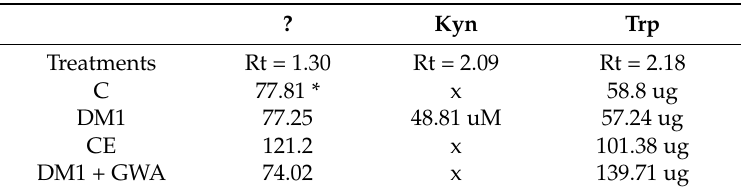
Table 4. Composition of amino acids present in plasma of rats submitted to treatments, evaluated by HPLC. ? Kyn Trp Treatments Rt = 1.30 Rt = 2.09 Rt = 2.18 C 77.81 * x 58.8 ug DM1 77.25 48.81 uM 57.24 ug CE 121.2 x 101.38 ug DM1 + GWA 74.02 x 139.71